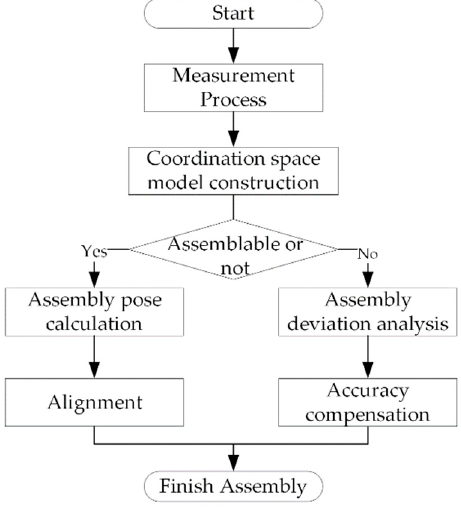
Figure 5. Assemblability analysis process.